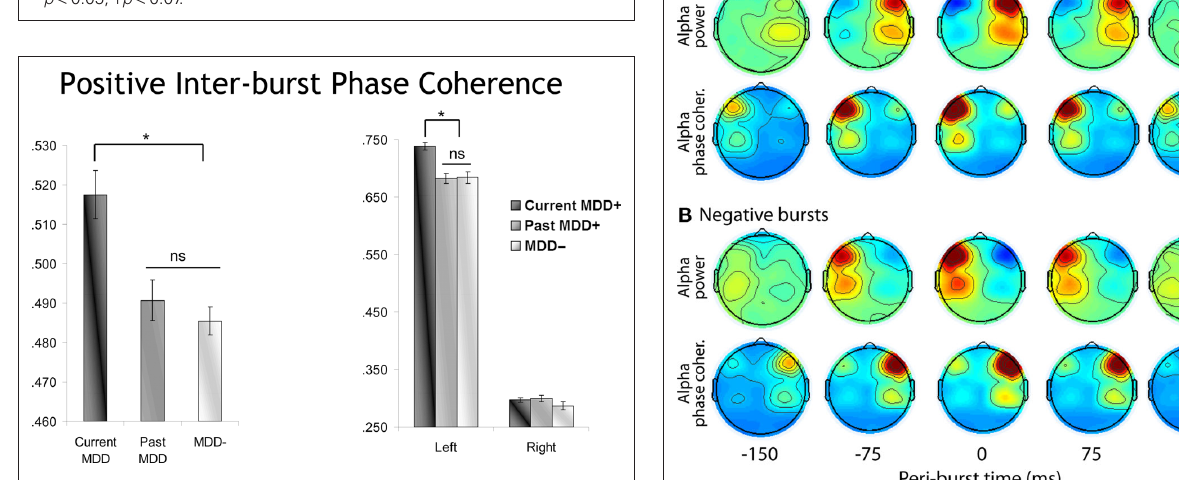
FIGuRE 9 | Number of negative bursts as a function of MDD status. Error bars reflect standard error. Both currently and previously depressed individuals had significantly more negative bursts than never-depressed individuals. * p < 0.05; † p < 0.07.